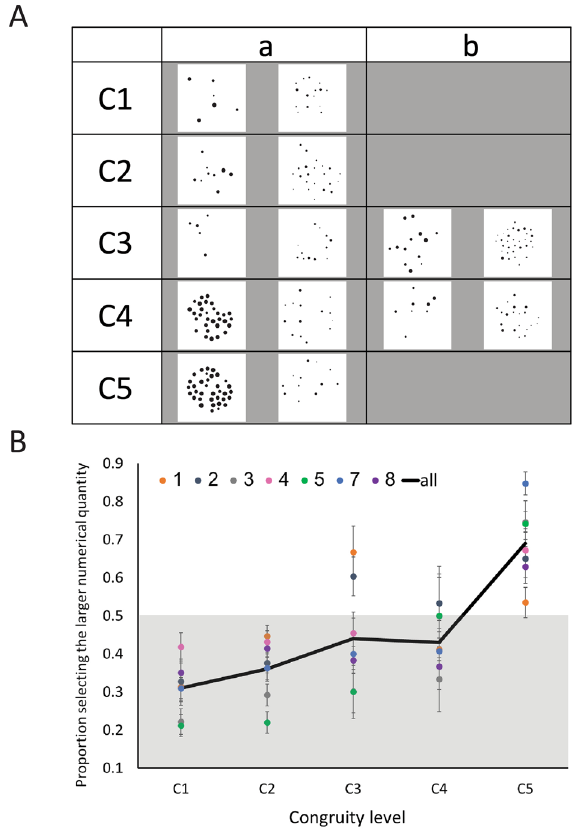
Figure 2. Non-numerical magnitudes influence magnitude-related decisions. ( A ) Examples for each congruity level and combination of non-numerical magnitudes. Please see Table 1 for reference as to the different combinations. ( B ) Results—the proportion of selecting the larger numerical quantity as a function of congruity level. The x-axis represents the congruity level between non-numerical magnitudes and numerical quantity. Congruity level one; only one out of five non-numerical magnitudes positively correlated with numerical quantity. The other four non-numerical magnitudes are negatively correlated with numerical quantity. Congruity level five: full congruity: all five non-numerical magnitudes positively correlated with numerical quantity. Each dot color represents one fish, and the black thick line represents the mean across fish. The gray area in the plot represents performance below chance level (for selecting the larger numerical quantity).